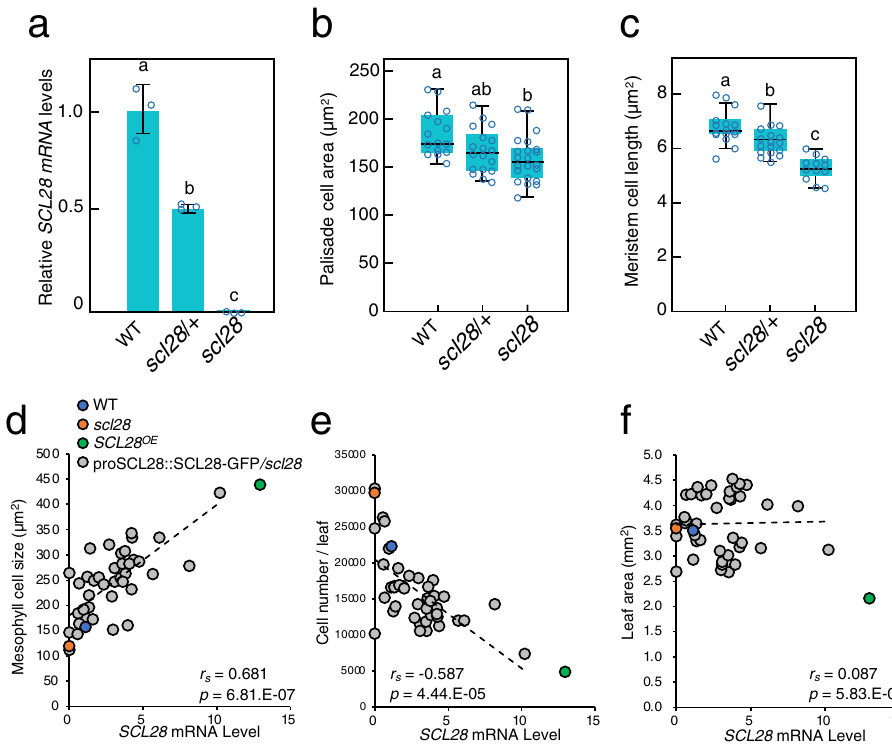
Fig. 8 SCL28 regulates cell size in a dose-dependent manner. a Moderate downregulation of SCL28 transcripts in plants heterozygous for scl28 . qRT-PCR analysis was performed using WT plants, and those heterozygous ( scl28 / + ) and homozygous ( scl28 ) for scl28 at 10 DAS. Data are shown as averages from three biological replicates (±SD). Statistical analysis was performed based on one-way ANOVA and Tukey ’ s test and signi fi cant differences ( P < 0.05) are shown in different letters above bars. b Quanti fi cation of palisade cell area in scl28 , scl28 / + and WT plants. Boxplot was generated using cell size data from 1st leaf pairs of multiple individual plants at 10 DAS (midline = median, box = IQR, whiskers = 1.5 × IQR). Numbers of plants analyzed were 15, 18, and 22 for scl28 , scl28 / + and WT, respectively. In each plant, more than 70 cells were analyzed for calculating average, which were further used for statistical analysis. Different letters above boxplots indicate signi fi cant differences ( P < 0.05) based on one-way ANOVA and Tukey ’ s test. c Quanti fi cation of cortical cell length in root meristems of scl28 , scl28 / + and WT plants. Boxplot was generated using cell size data from roots of multiple individual plants at 7 DAS (midline = median, box = IQR, whiskers = 1.5 × IQR). Numbers of plants analyzed were 16, 17, and 12 for scl28 , scl28 / + and WT, respectively. In each plant, more than 30 cells were analyzed for calculating average, which was further used for statistical analysis. Different letters above the boxplots indicate signi fi cant differences as in ( b ). d Correlation between SCL28 mRNA levels and palisade cell size analyzed by scatterplots, where each dot corresponds to each individual plant from different transgenic lines carrying proSCL28::SCL28-GFP under scl28 background. In addition to proSCL28::SCL28-GFP plants (shown in gray dots), WT (blue dot), scl28 (red dot), and SCL28 OE plants (green dot) were also analyzed. e Correlation between SCL28 mRNA levels and number of palisade cells per leaf was analyzed by scatterplot as in ( d ). Symbols are same as in ( d ). f Correlation between SCL28 mRNA levels and leaf area was analyzed by scatterplot as in ( d ). Symbols are same as in ( d ). Values in ( d – f ) represent Pearson correlation coef fi cients ( r s ) and its two-sided P value without adjustment ( p